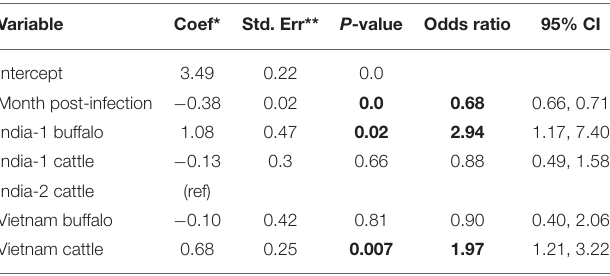
TABLE 7 | Generalized linear mixed model for the probability of FMDV RNA recovery from oropharyngeal fluid following an FMD outbreak across three studies.